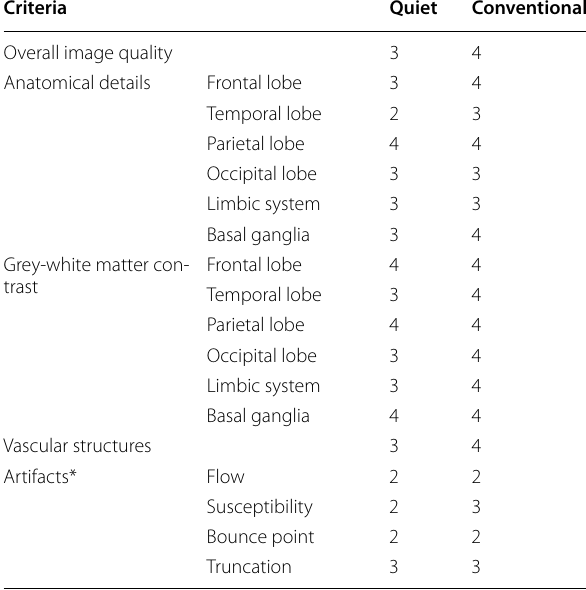
Table 2 Average image scores of the two observers for both sequences on visibility of anatomical details and grey-white matter contrast and delineation of vascular structures using a 5-point Likert scale: 1 very poor, 2 poor, 3 acceptable, 4 good, and 5 excellent